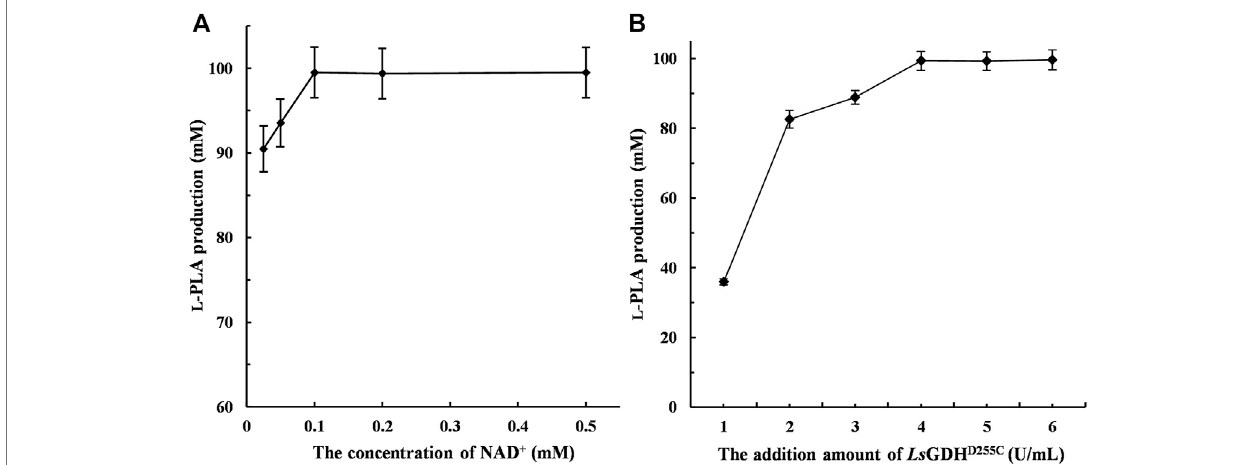
FIGURE. 5 | Effect of the concentration of NAD + and Ls GDH D255C on L-phenyllactic acid (L-PLA) production. (A) Effect of the concentration of NAD + on L-PLA production. (B) Effectofthe Ls GDH D255C amountonL-PLAproduction.Thebioconversionwasconducted in50 mMsodium acetate – acetatebuffer (pH5.0)containing 100 mM PPA and 120 mM glucose at 40 ° C for 1 h. Means and standard deviations of triplicate experiments are shown.